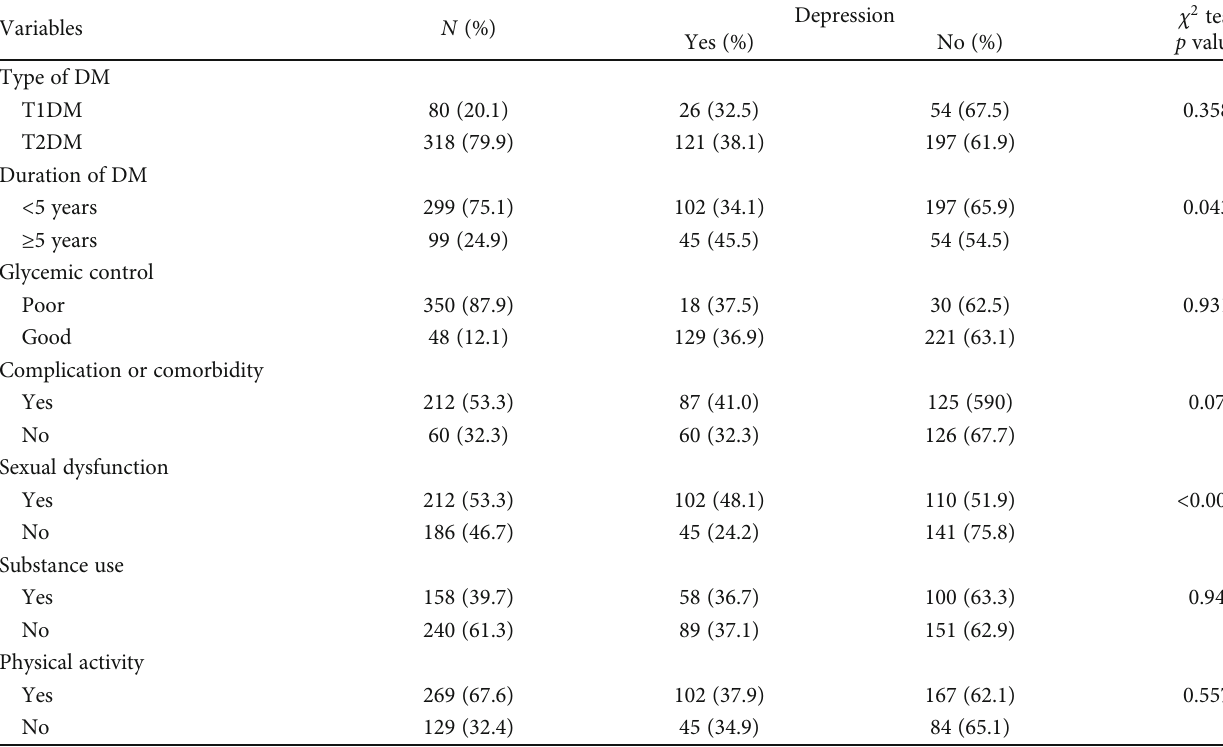
Table 2: Behavioral and medical-related factors of diabetes patients on follow-up in MTUTH and TGH, Southwest Ethiopia, July 2018 ( n = 398 ).